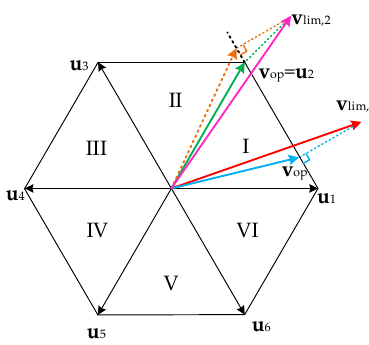
Figure 1. The OVV with voltage constraint.